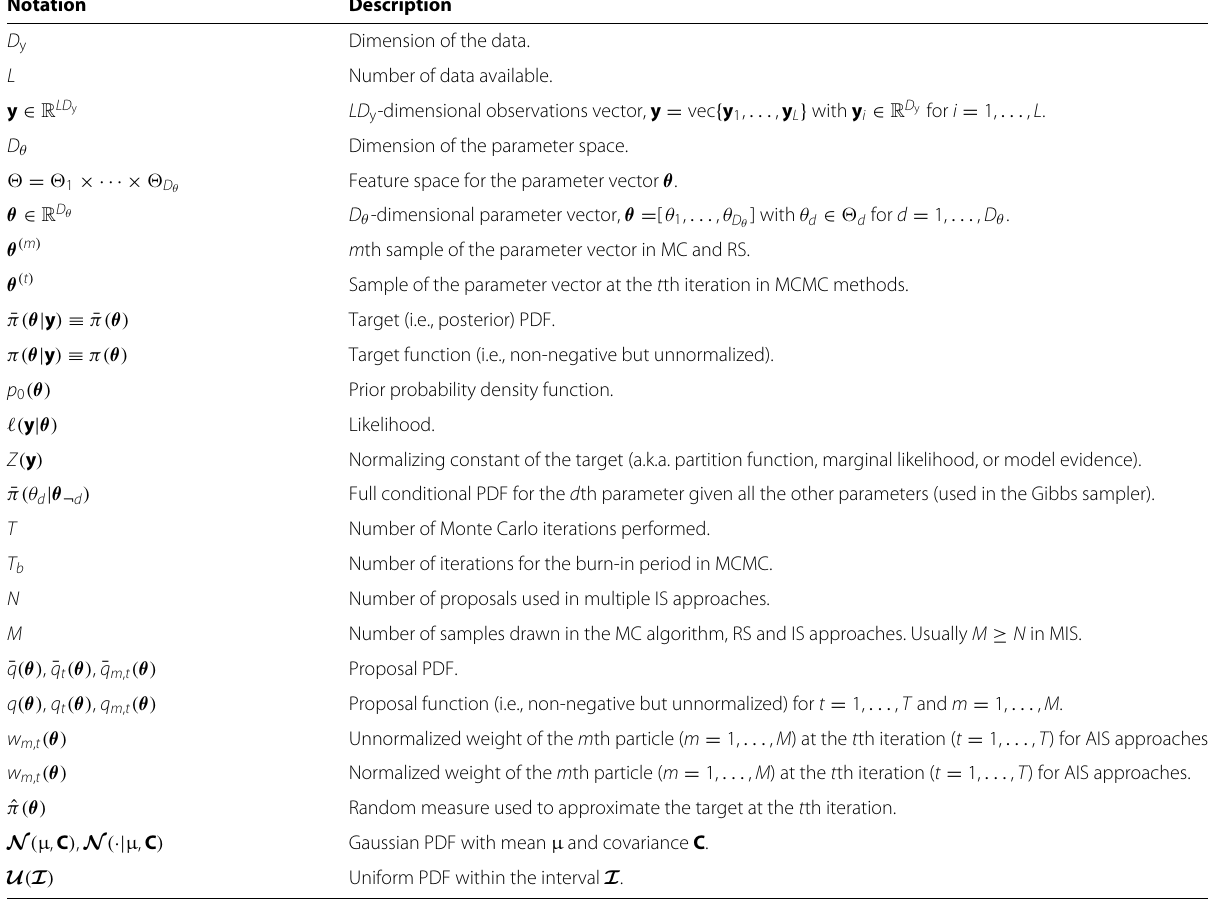
Table 2 Summary of the main notation used throughout the